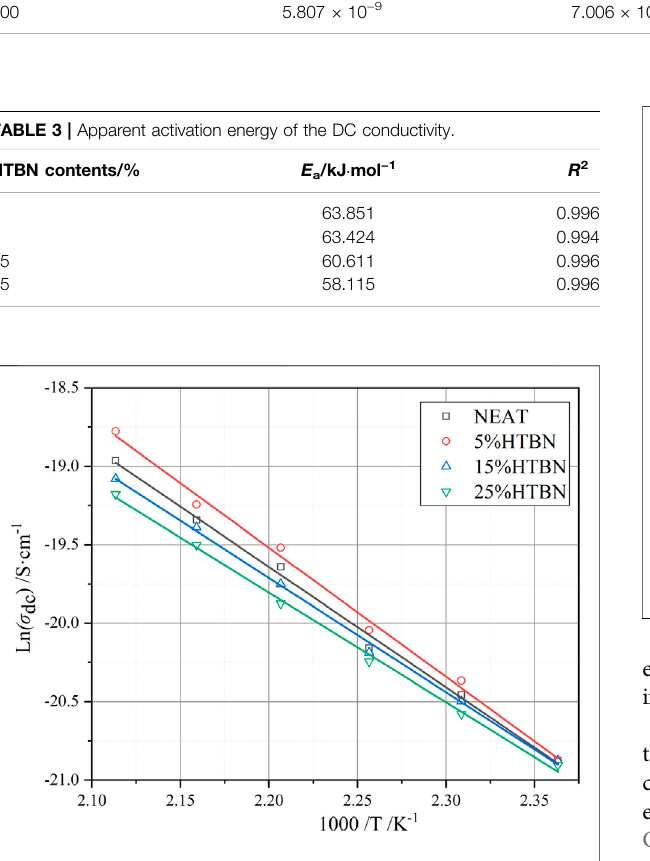
FIGURE 10 | Variation of DC conductivity with temperature for different samples.